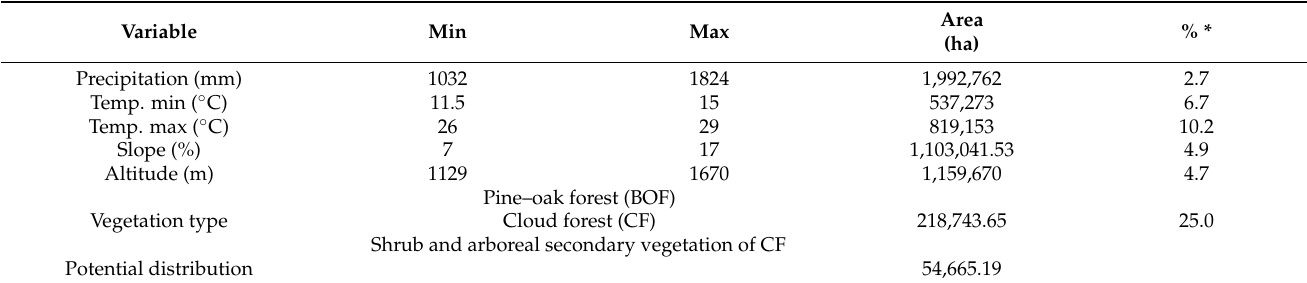
Table 1. Multi-criteria analysis for the potential distribution of Euphorbia fulgens .